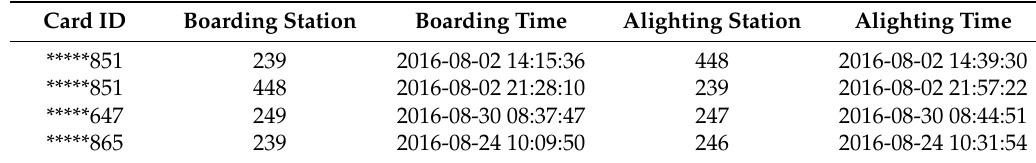
Table 1. The format of reconstructed trip